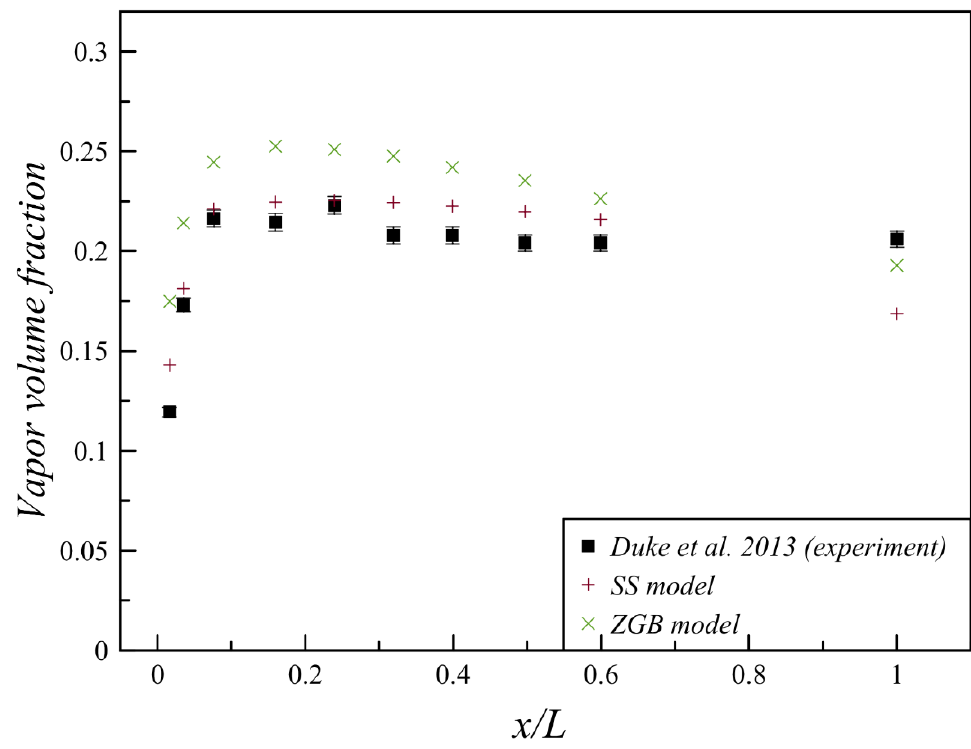
Figure 8. Comparison of predicted total vapor volume fraction using two cavitation models with experimentally measured total vapor volume fraction across the nozzle at different axial positions along the nozzle. Error bars in the experimental data show uncertainty of around 2% [15].